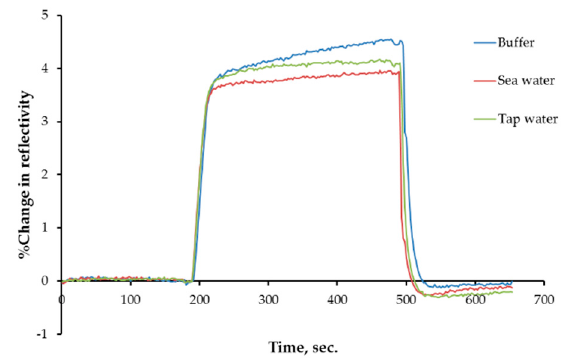
Figure 8. Water sample analyses results.